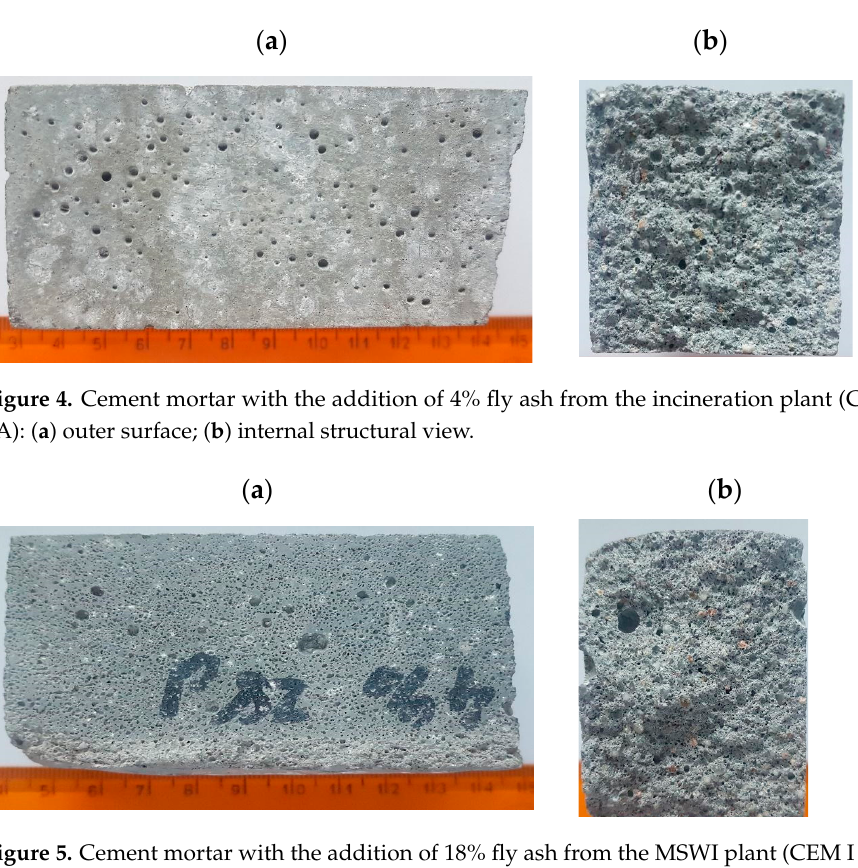
Figure 5. Cement mortar with the addition of 18% fly ash from the MSWI plant (CEM I + 18% FA): ( a ) outer surface; ( b ) internal structural view. reference value.